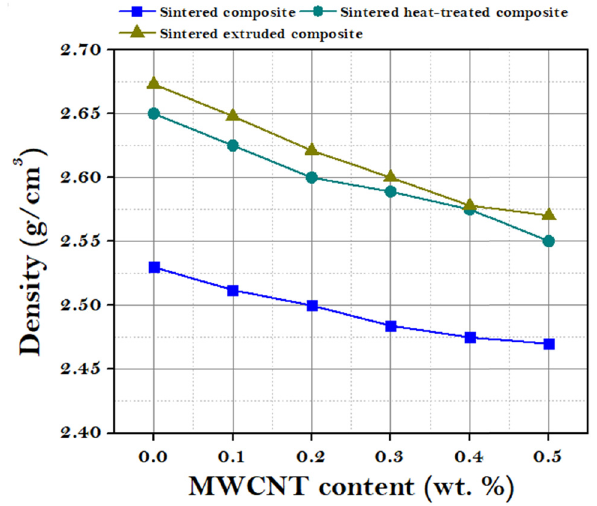
Figure 6: Density of the composites with varying weight percentages of